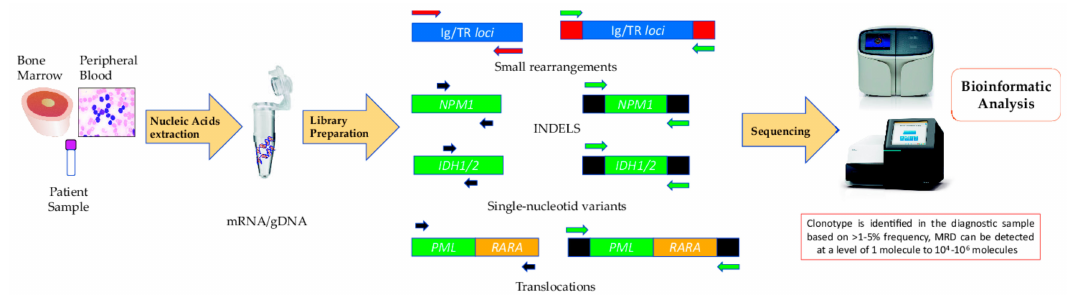
Figure 1. High-throughput sequencing workflow for minimal residual disease